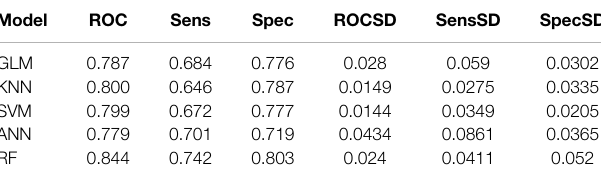
TABLE 2 | Prediction performance of models for down-regulation pairs using the 5-fold cross validation on the training dataset.